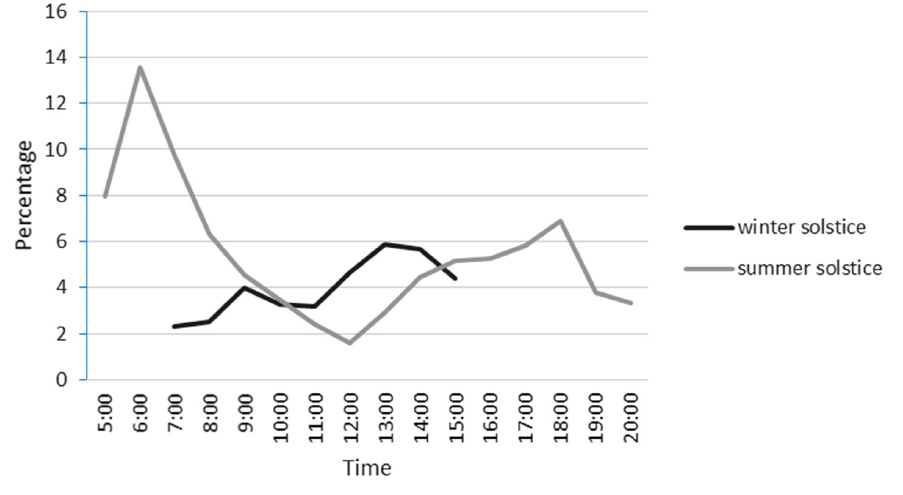
Figure 11. Percentage increase in average hourly solar radiation received for the winter and summer